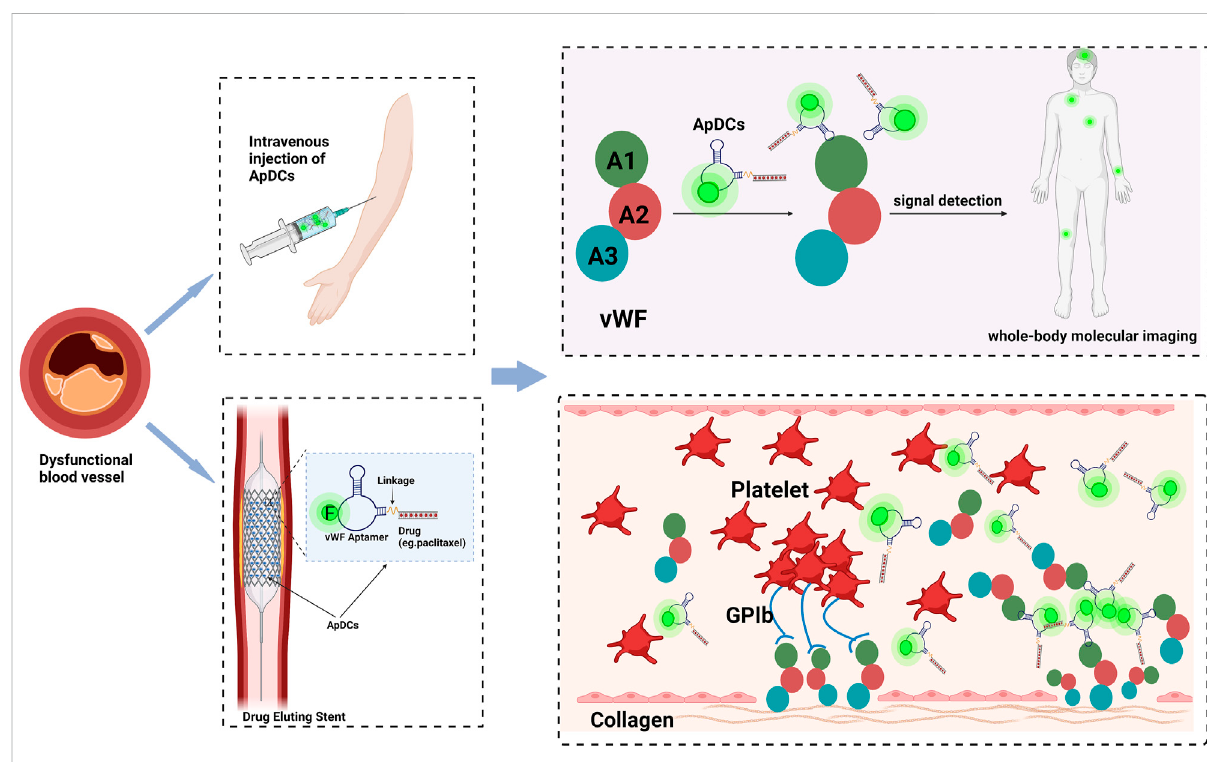
Aptamer-based applications in cardiovascular disease to realize the integration of diagnosis and treatment in the future. (Take vWF as an instance.). The drug is coupled to the vWF aptamer by covalent bonding to construct the aptamer-drug conjugates and then injected intravenously orsubcutaneously.Aptamer-drugconjugatescanbealsoimmobilizedonthesurfaceofthestent,andentersthebodywiththestentimplantation.As theywill assemble atthesitesofstressed endothelium, therelevant signalsatlesions canbecaptured bydetection machines, meanwhile lifting the drug concentration at the injured sites locally, to establish a point-to-point interface to achieve controlled drug release, reducing the complications of bleeding and realizing disease treatment with visualization. Created with